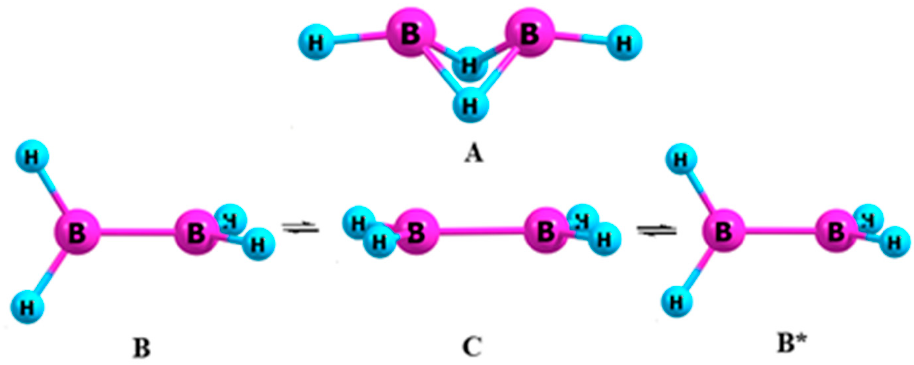
Figure 8. Forms ( A )–( C ) of diborane. Adapted with modification [175].